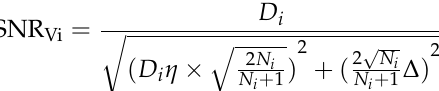
Figure 12. Relative power intensity of the light source. The curves are obtained by the column scan mode with the orders of 107 and 227.